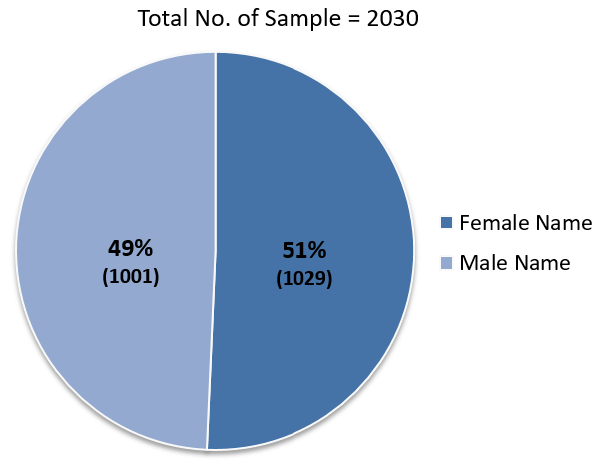
Figure 1. Dataset overview.